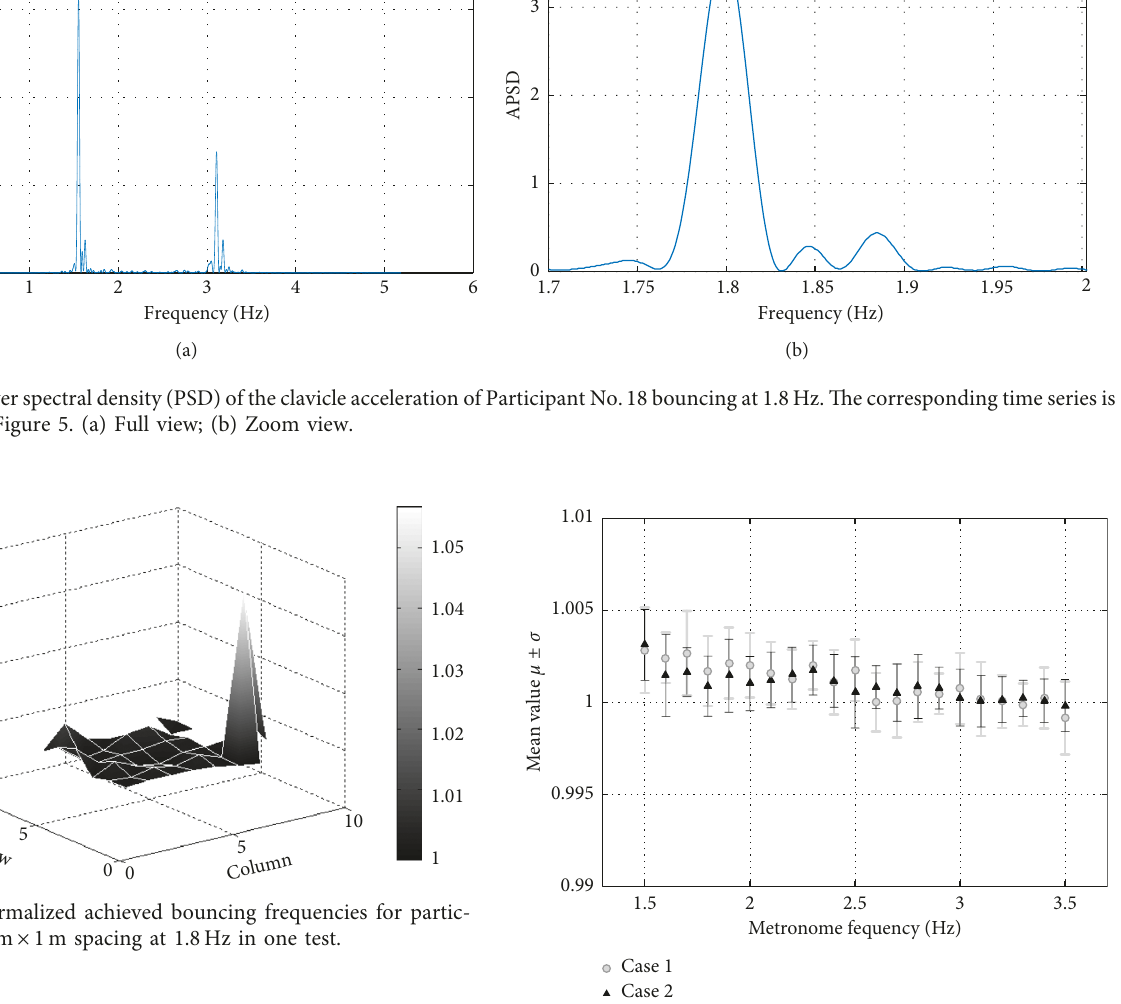
Figure 9: Distribution summary of normalized achieved fre- quencies in two tests for the reference